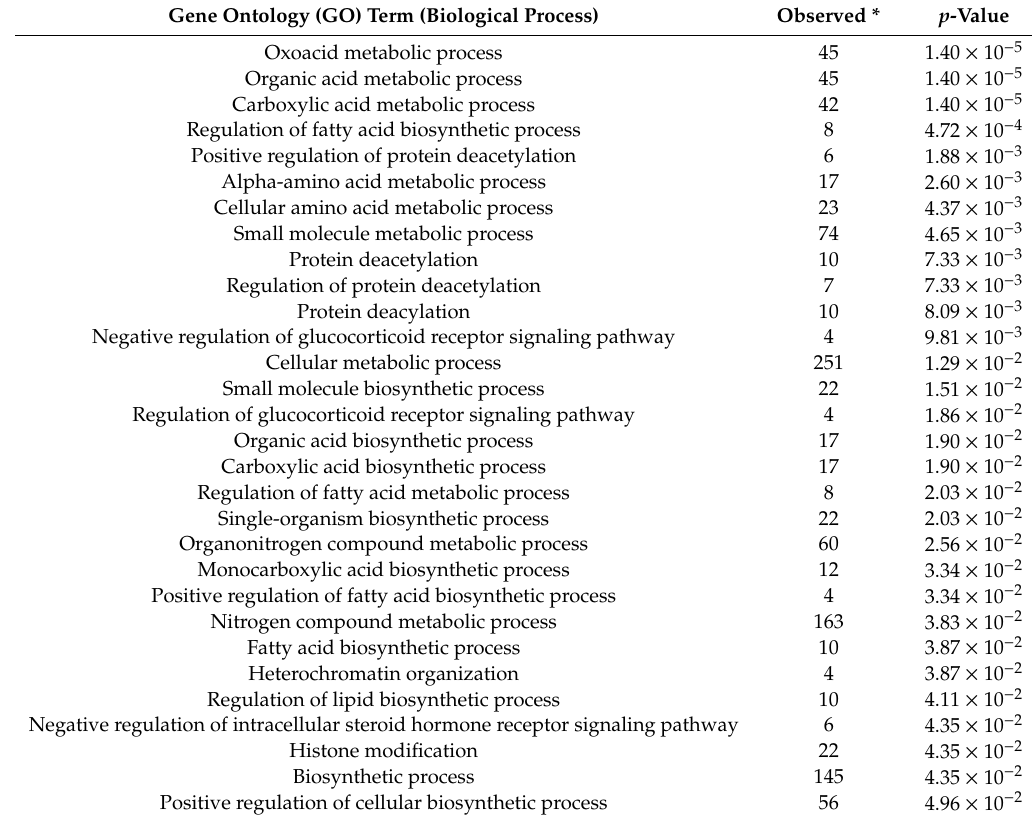
Table 3. Biological process enriched by the di ff erentially expressed mRNAs. Gene Ontology (GO) Term (Biological